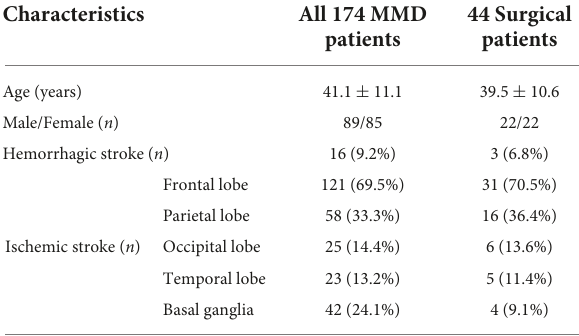
TABLE 2 The correlation between dynamic susceptibility contrast-cerebral blood flow (DSC-CBF) and arterial spin labeling (ASL)-CBF before revascularization.